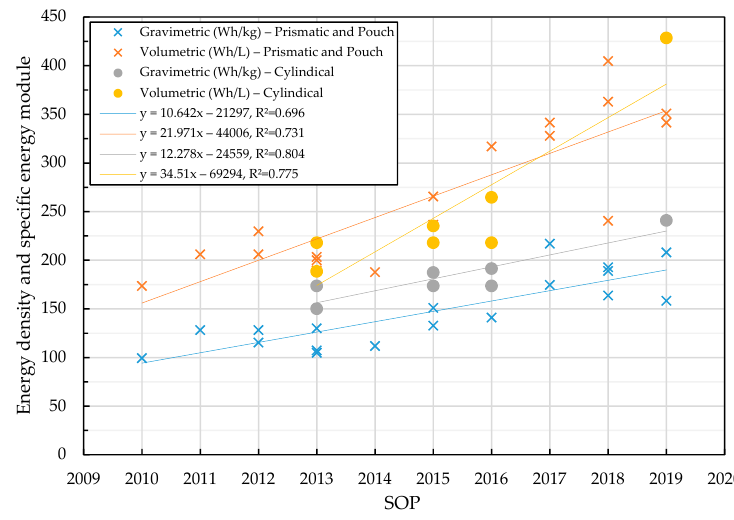
Figure 5. Energy density development on module level in the years between 2010 and 2019.